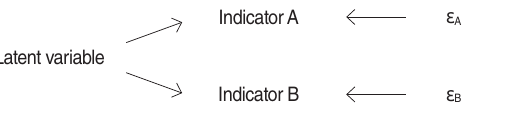
Figure 1. The local independence assumption. ε , measurement error.